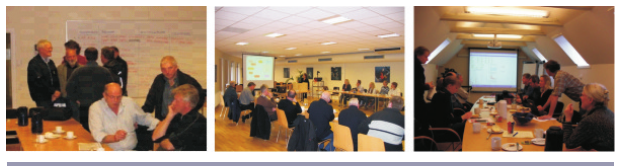
Fig. 3. Limfjord stakeholder meetings. From